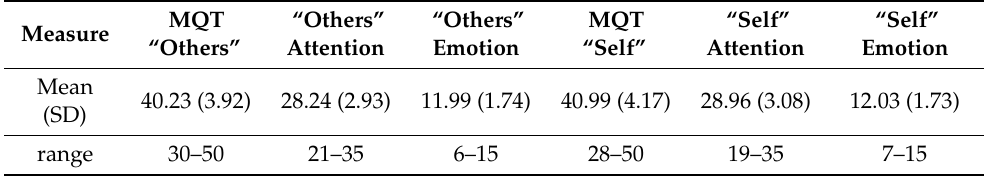
Table 8. Descriptive statistics of the MQT, separate for the two sum scores of the (shortened 10-item) “others” and “self” subscales and the respective “attention” and “emotion” factor sum scores for the whole sample of N = 273 participants.